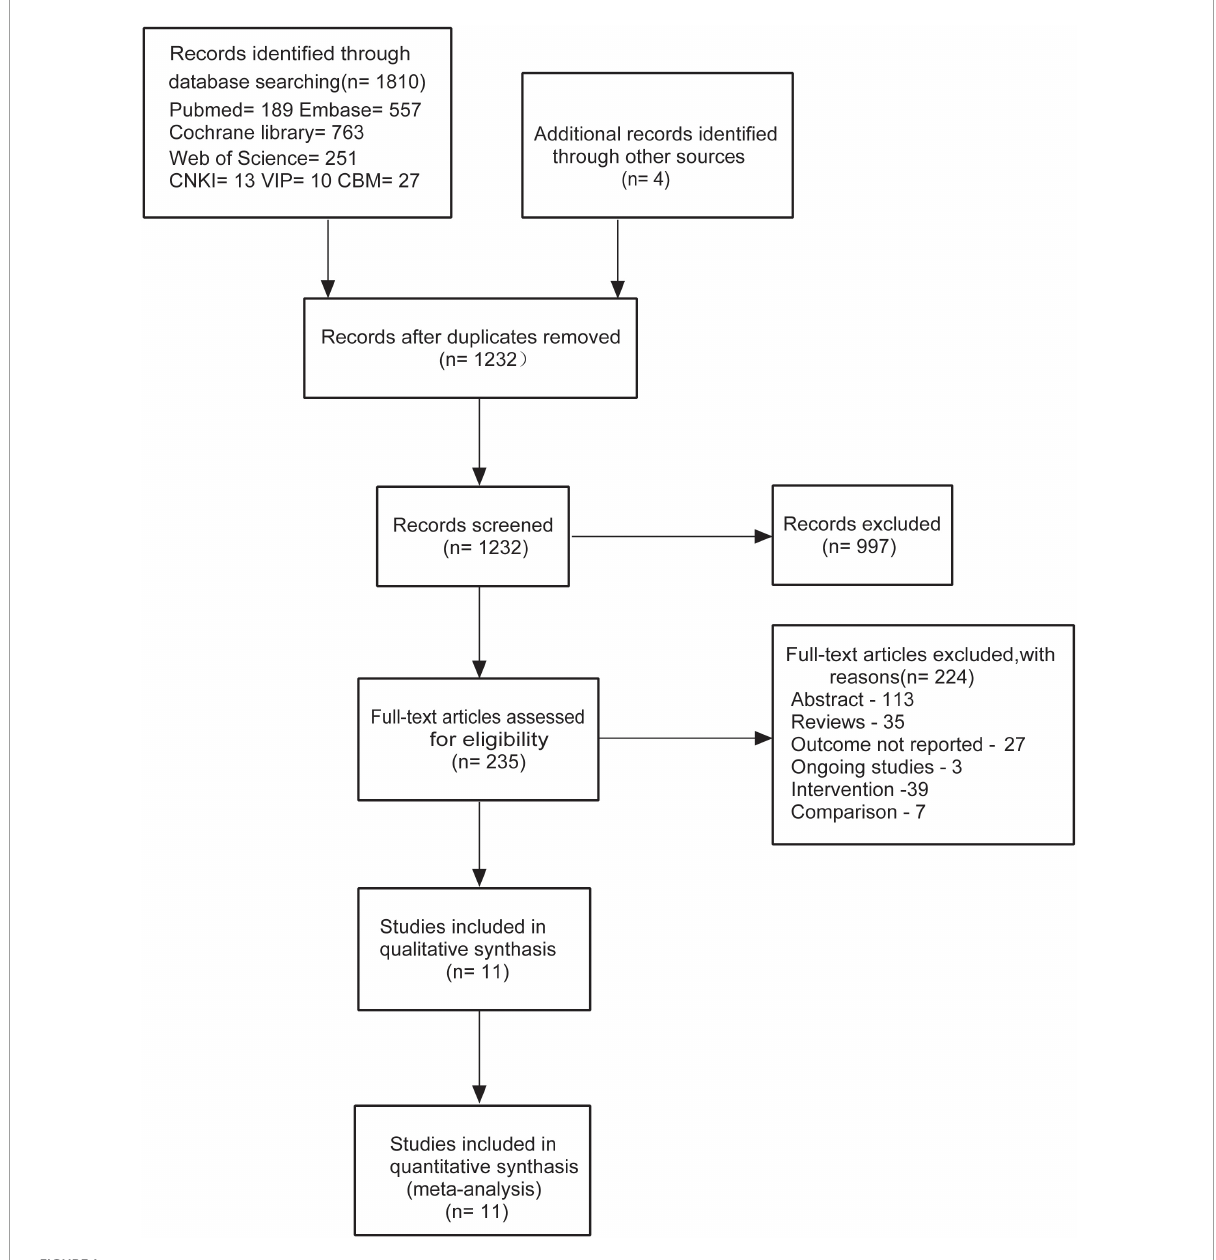
FIGURE1 Flow diagram for the identification of relevant clinical trials examining the effect of fruits or fruit products on patients with functional constipation